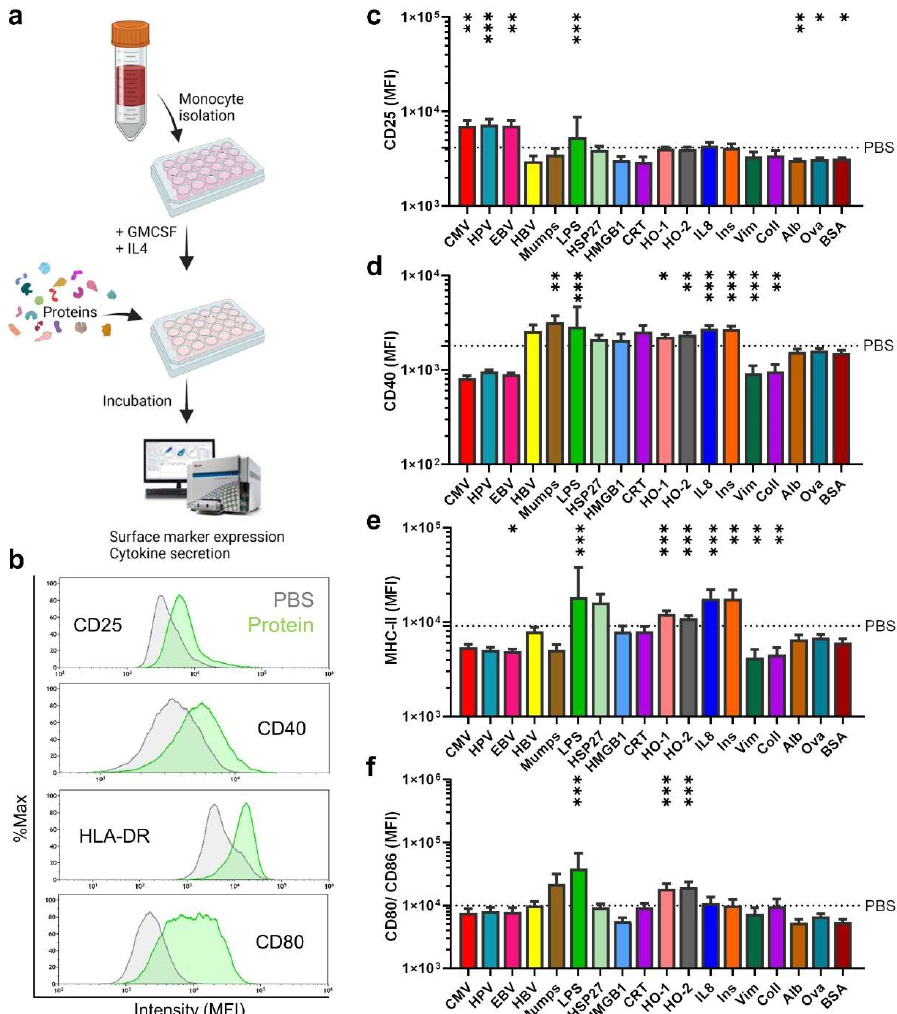
Figure 1. Monocyte-derived cells surface marker expression after uptake of different proteins. ( a ) scheme of the workflow to investigate the effect of proteins on monocyte-derived cells; ( b ) repre- sentative histogram of surface marker expression of CD25, CD40, HLA-DR, and CD80 investigated using flow cytometry 24 h after stimulation with the proteins; ( c – f ) quantification of activation marker CD25 ( c ), co-stimulatory receptor CD40 ( d ), maturation marker HLA-DR ( e ), and co-stimu- latory and activation markers CD80/CD86 ( f ). Data are mean of six independent experiments, nor- malized to each corresponding native protein. Statistical analysis was performed using Mann–Whit- ney Test comparing each protein to PBS (* = p < 0.05, ** = p < 0.01, *** = p < 0.001).